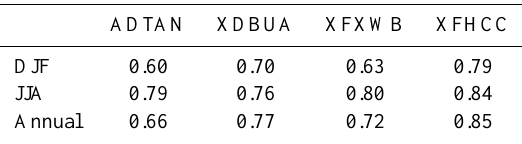
Table 1. Arcsin-Mielke skill scores for surface temperature pole- ward of 45 ◦ N with respect to HadCM3 in different versions of FA- MOUS. Potential scores range from 1 to − 1, with 1 denoting a per- fect match between fields, 0 implying no correlation at all and − 1 perfect